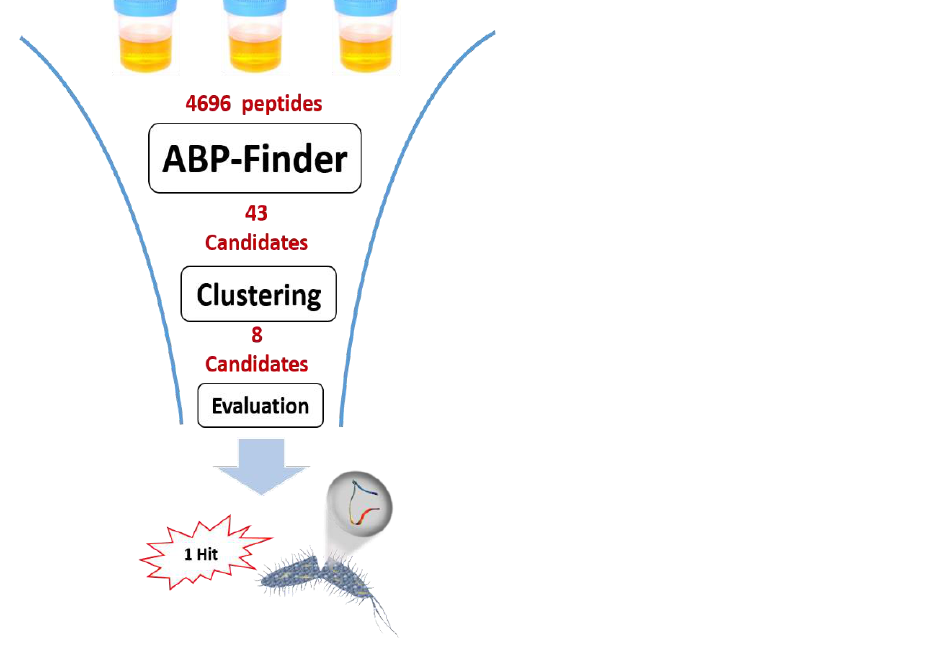
Figure 5. Schematic representation of the virtual screening process carried out on a library of peptides from the human urine peptidome.